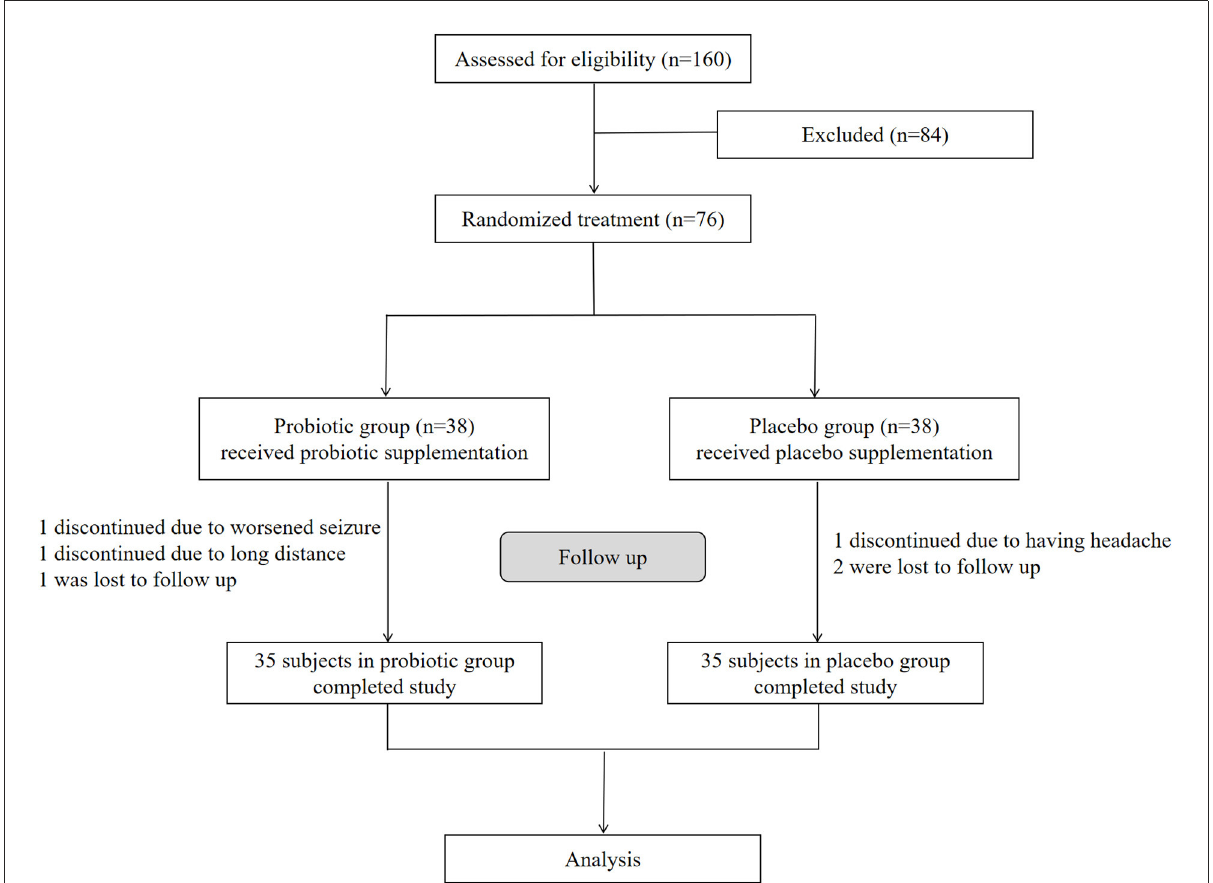
FIGURE1 Enrollment, randomization, and follow-up of the participants. Seventy six enrolled participants were equally and randomly assigned to the probiotic and placebo groups. After follow-up, 35 participants in probiotic group and 35 in placebo group finally completed the study respectively for